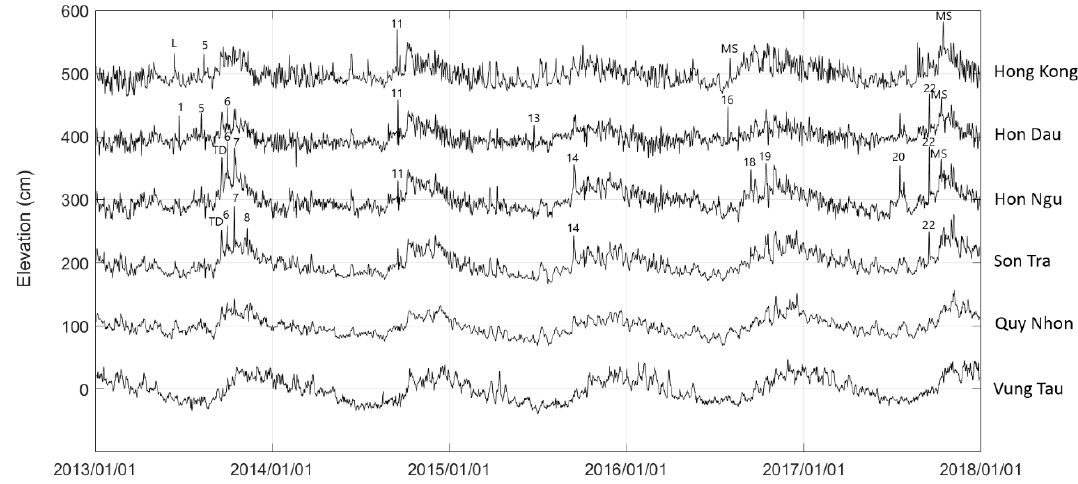
Figure 6. Time series of low frequency water levels from 2013 to 2017. Note that each time series is displaced by 100 cm. Key to numbers referring to typhoons: 1–TS Bebinca (June-13), 5–TY